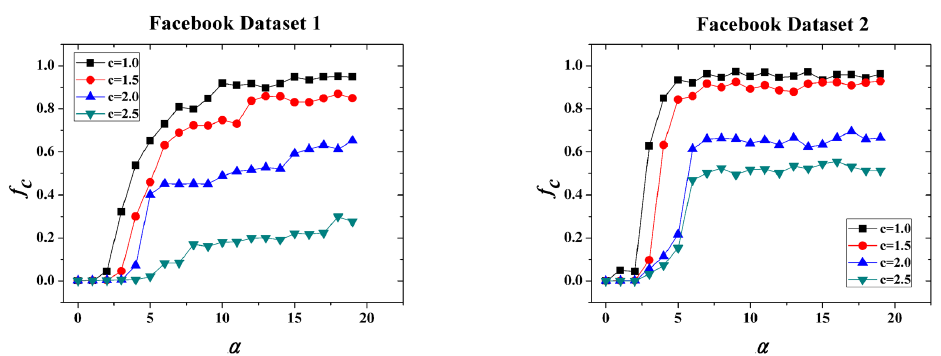
Figure 3. The fraction of cooperators in equilibrium ( f C ) vs a for different values of c . We set b ~ 20 as a constant in all simulations. The two figures show that the increase of c prohibits cooperation since greater c decreases the cooperators’ payoff. Moreover, there is a positive relationship between the preference a and f C indicating that preferentially allocating investments to good friends promotes